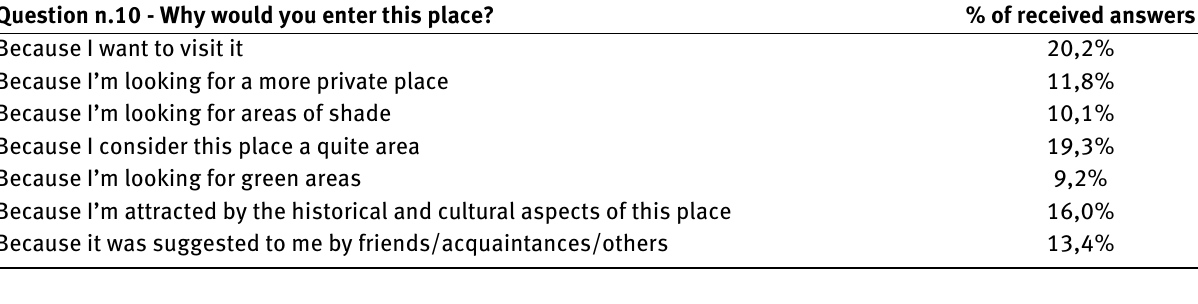
Table 3: Answers to question related to the motivation to attend the study areas Question n.10 - Why would you enter this place?